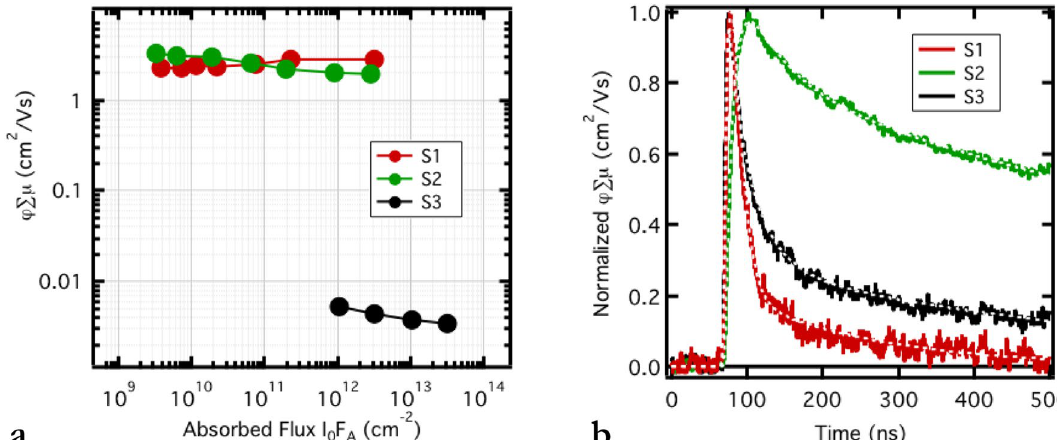
Figure 3. Plots of ( a ) φΣμ versus absorbed photon flux and, ( b ) normalized photoconductivity transients for CISe films S1( B ), S2( B ) and S3 with fits shown as dashed gray